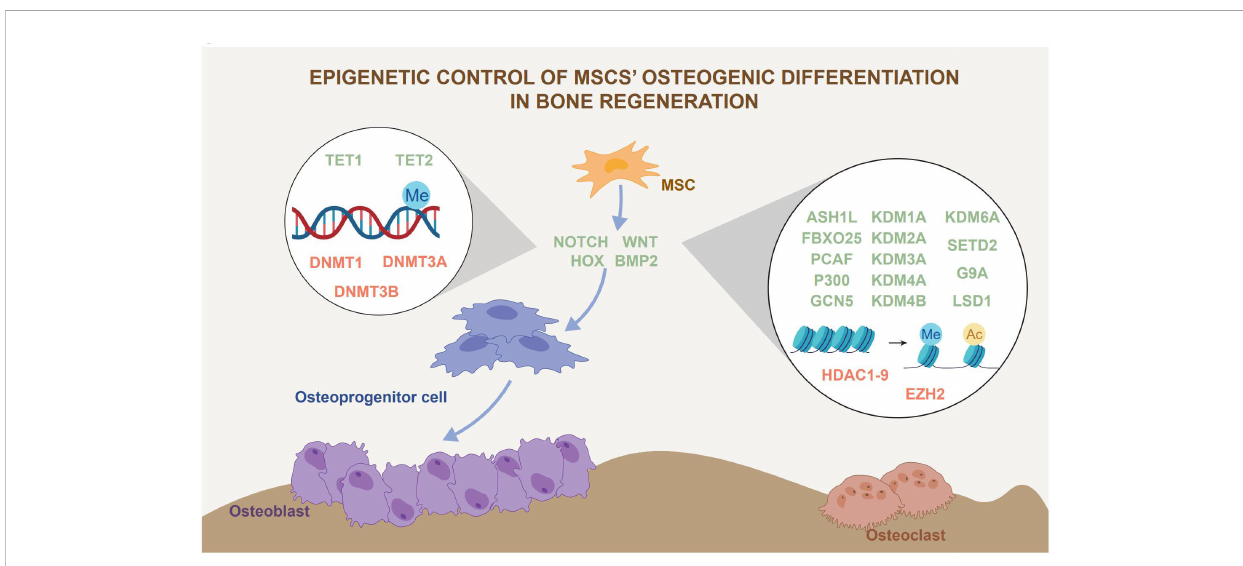
FIGURE 2 Epigenetic control of MSCs osteogenic differentiation in bone regeneration. Epigenetic regulation, represented by histone modi fi cation and DNA methylation, has an impact on MSCs osteogenic differentiation. Epigenetic regulation affects bone regeneration by in fl uencing the lineage commitment of MSCs. The green font represents promoters of osteogenic differentiation and the red font represents inhibitors of osteogenic